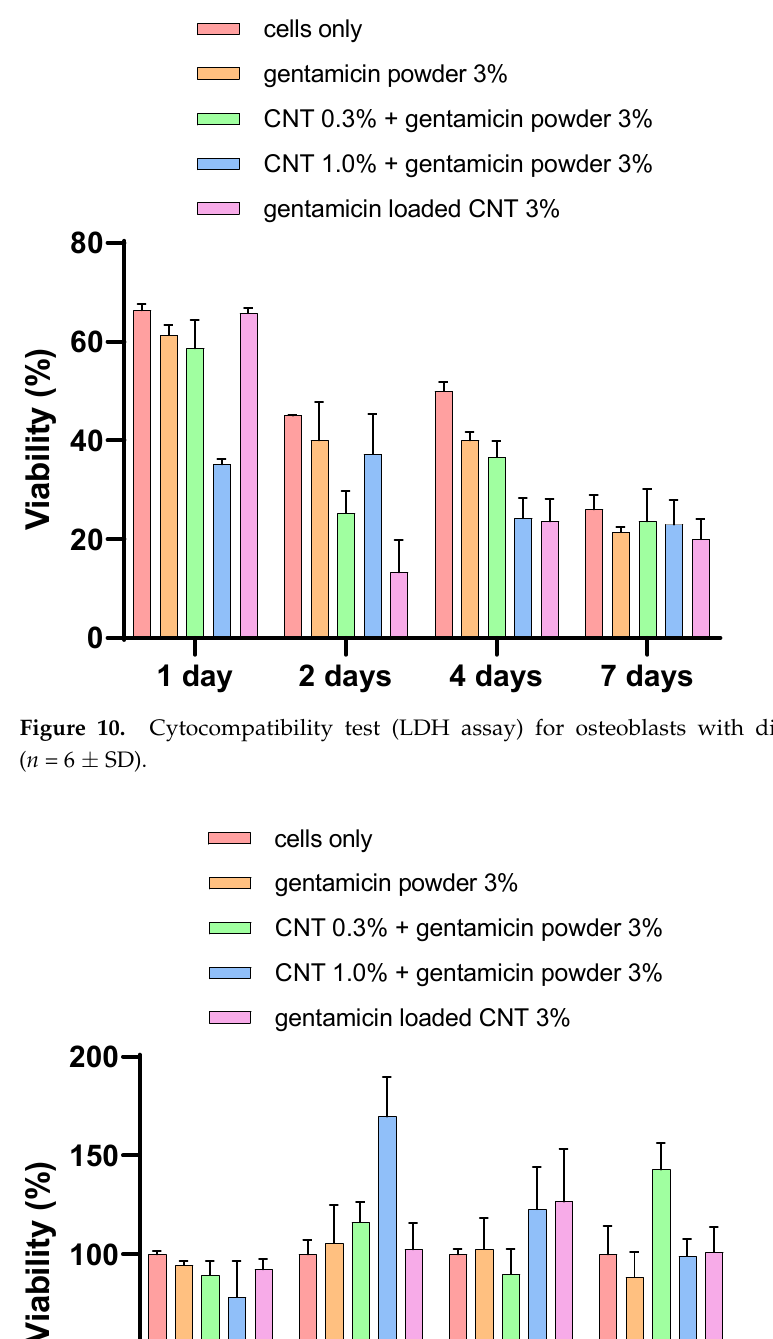
Figure 11. Cytocompatibility test (alizarin red assay) for different osteoblasts with different types of cement ( n = 6 ± SD).